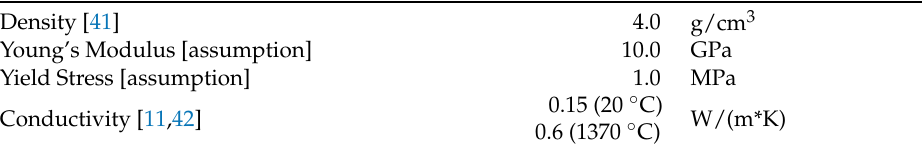
Table 2. Parameters for modeling 316L powder.